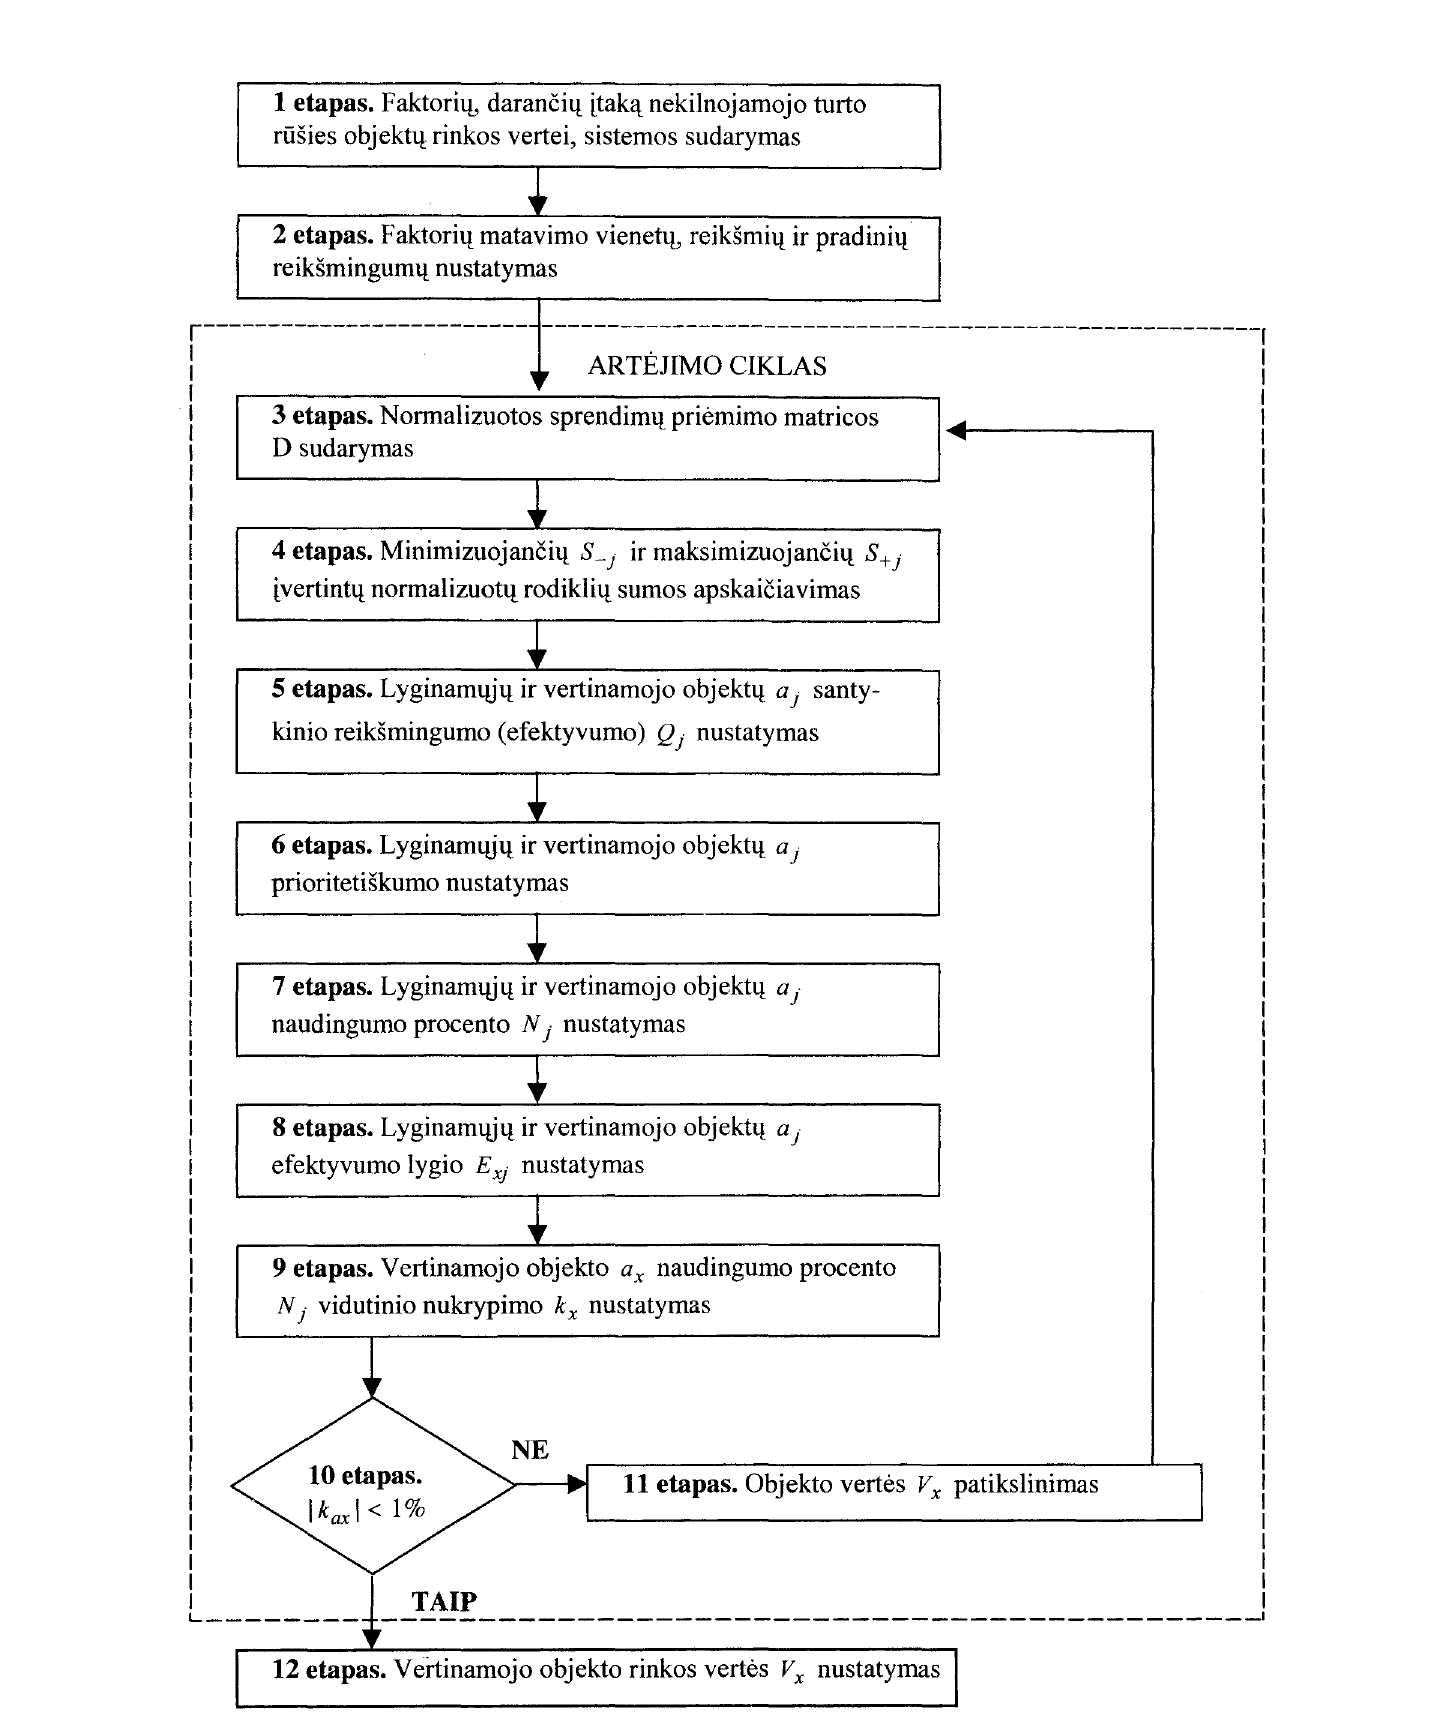
12 etapas. Vei:tinamojo objekto rinkos vertes Vx nustatyrnas 2 pav. Daugiakriterinio vertinimo metodo struktiirine schema Fig 2. Block diagram of multiple criteria valuation method